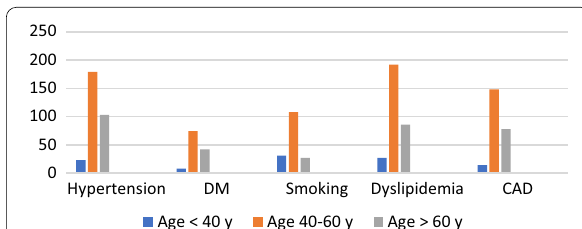
Fig. 4 Comparison of clinical characteristics among different age groups